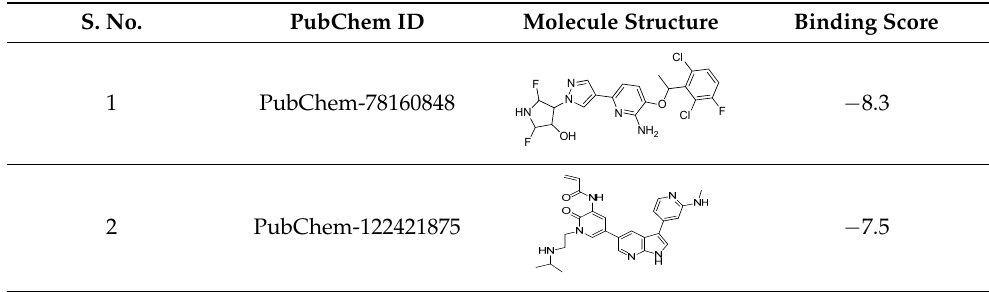
Table 1. Two-dimensional structures of the best binding molecules to the active site of the AXL kinase with its binding energies (in kcal/mol) . S. No.